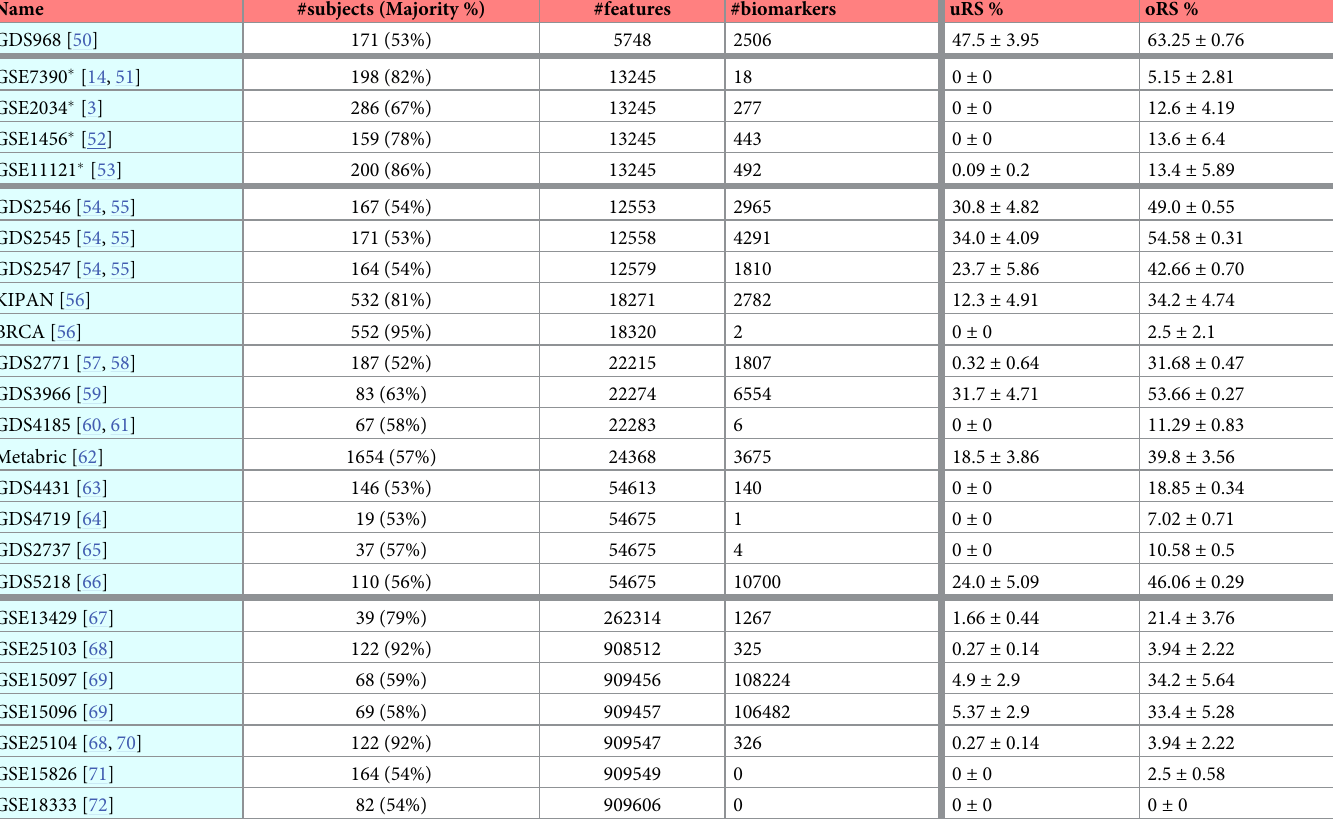
Table 1. Results for all 25 datasets when using all the subjects. This table is sorted by sample size (#subjects)–corresponding to Fig 5. The first 18 entries are Gene Expres- sion datasets (including the 4 “ � ”ed entries, from the Zou et al. [8] meta-study), and the final 7 are SNP datasets. Reproducibility Scores are shown in the form of mean ± standard deviation. The “(Majority %)” values are the percentage of the subjects in the dataset with the more common outcome– e.g. , 53% of the subjects in the GDS968 dataset are labeled “+” (for “long survival time”), and 82% of GSE7390 are labeled “ − ” (for